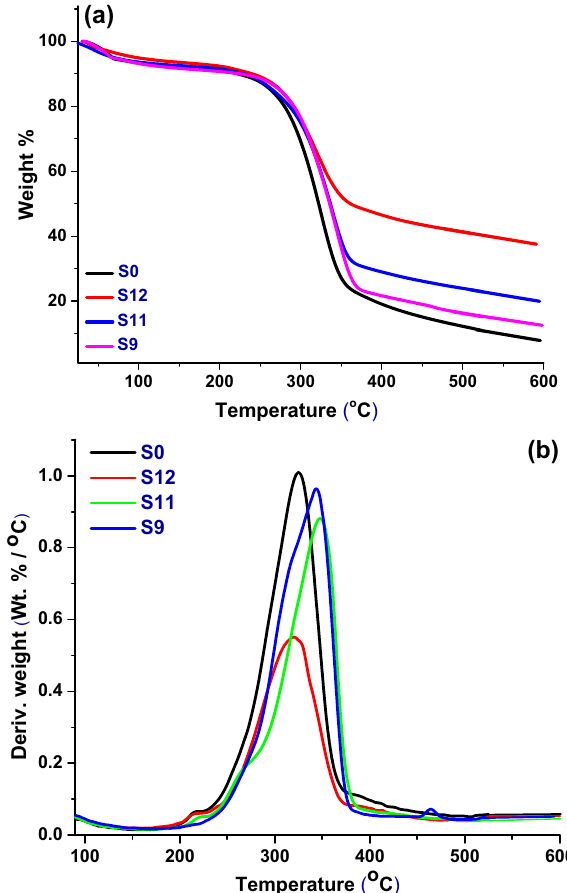
Figure 7. TGA ( a ) and DTG ( b ) profiles of printed papers, S0 (blank bagasse), S9 (20% CaCO 3 + 0.1% CPAM + 1% Bt), S11 (20% RHSA + 0.1 % CPAM + 1 % Bt) and S12 (20% TiO 2 /RHSA + 0.1 % CPMA + 1%